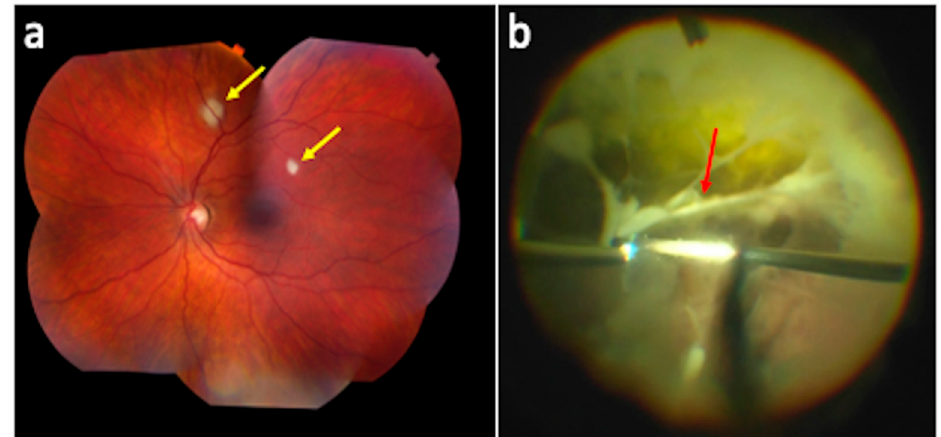
Figure 3. Intraocular fungal complications. A patient with candida chorioretinitis ( a , yellow arrows) versus a patient with candida chorioretinitis with a “string of pearls” ( b , red arrow).